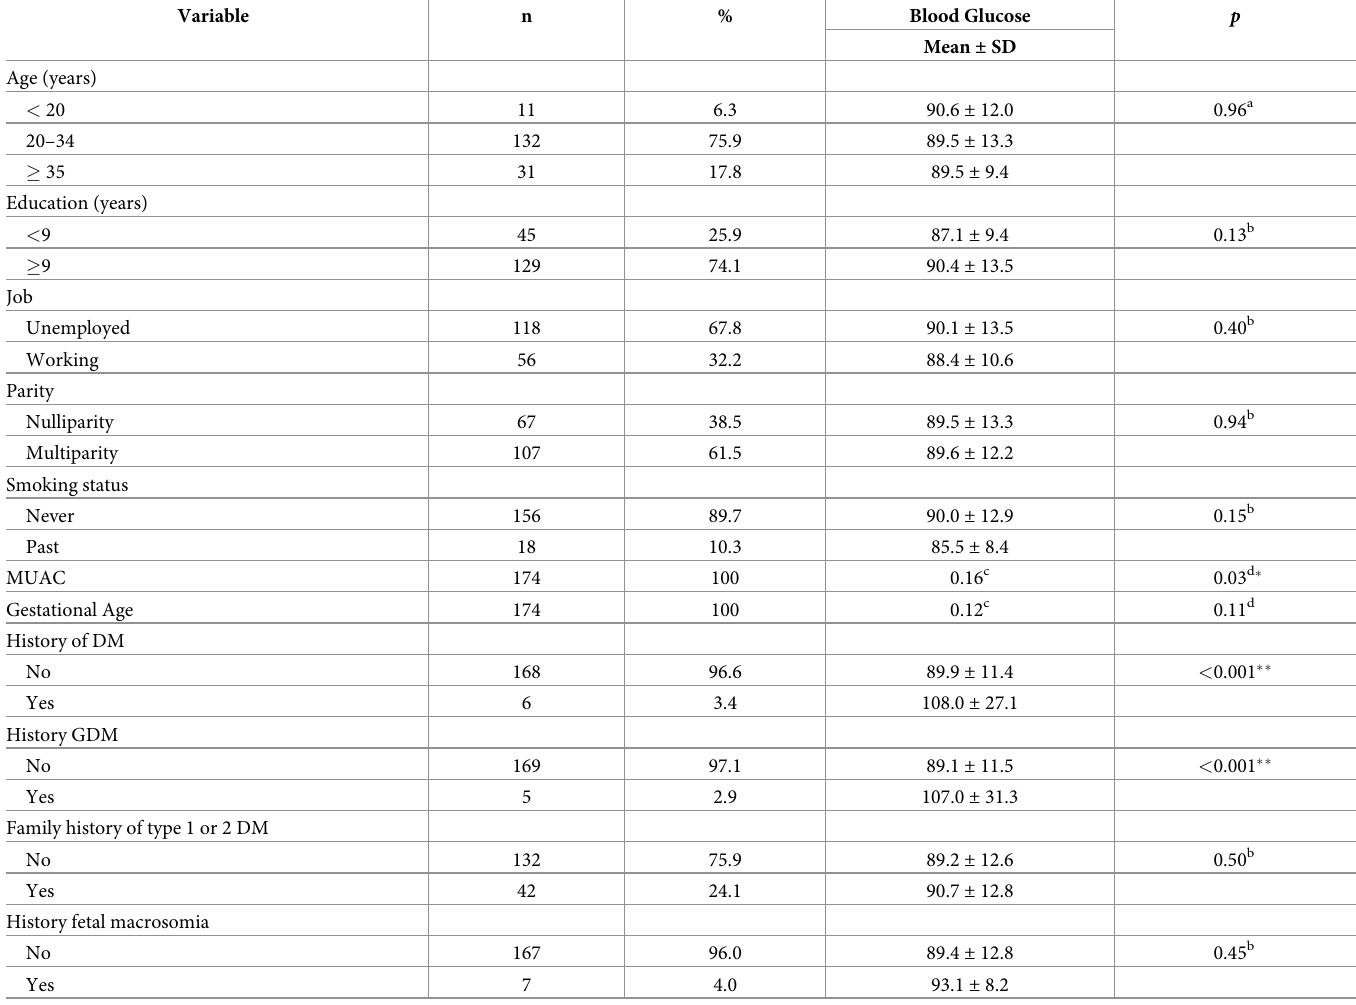
Table 3. Relationship of potential covariates and diet quality with blood glucose of pregnant women (n = 174).